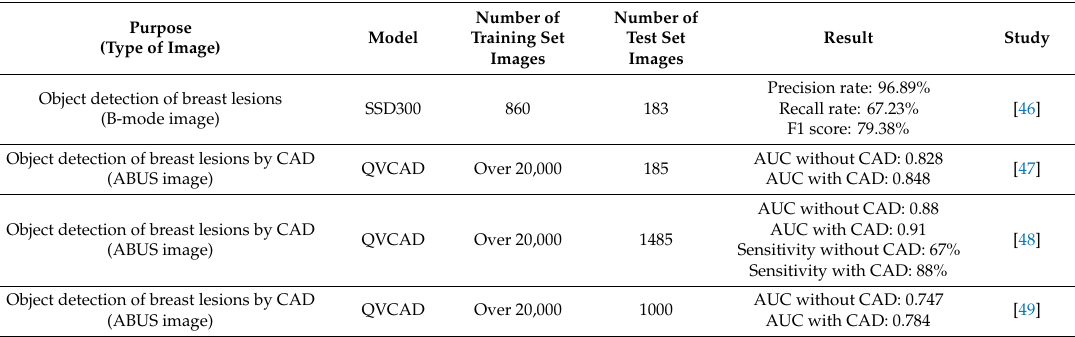
Table 2. Deep learning models for object detection.